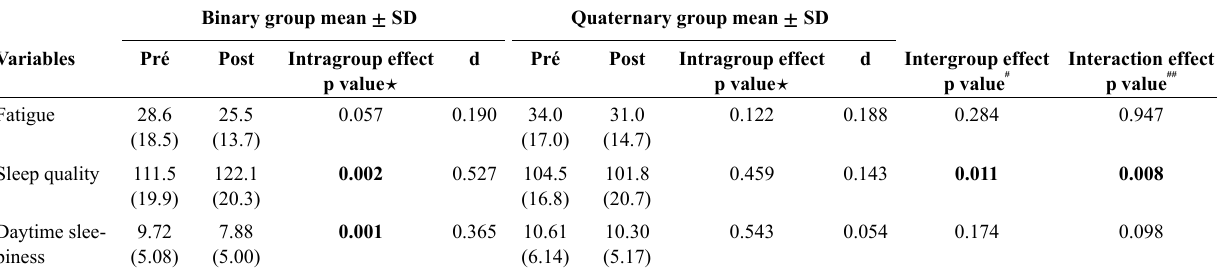
Table 4 - Comparison of fatigue, sleep quality, and daytime sleepiness between the binary and quaternary groups of the study